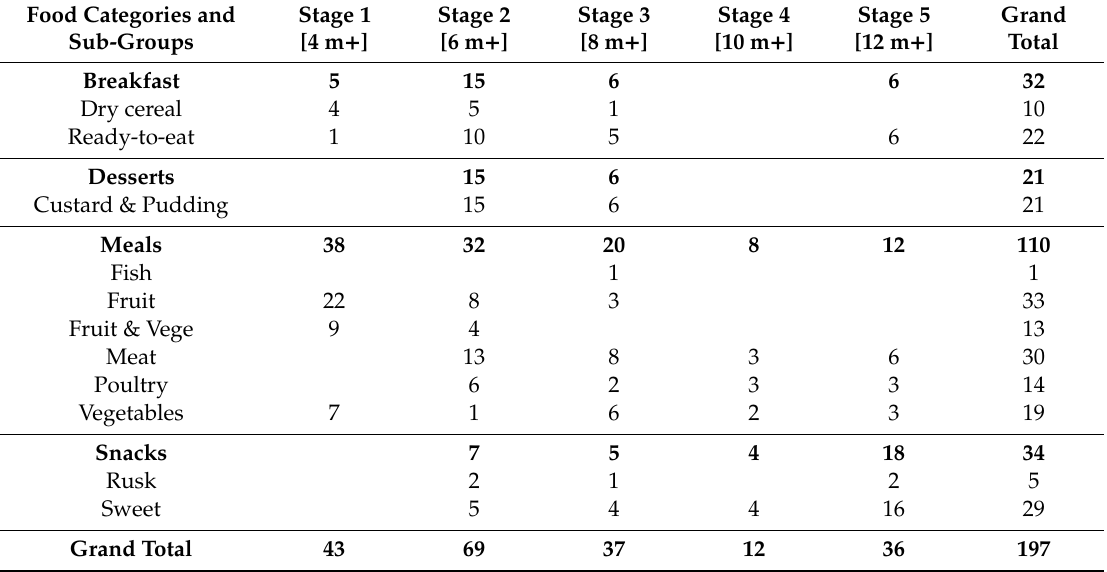
Table 1. Count of commercially available complementary foods (CACFs) in New Zealand supermarkets in 2019, stratified by food categories and sub-groups ( n =